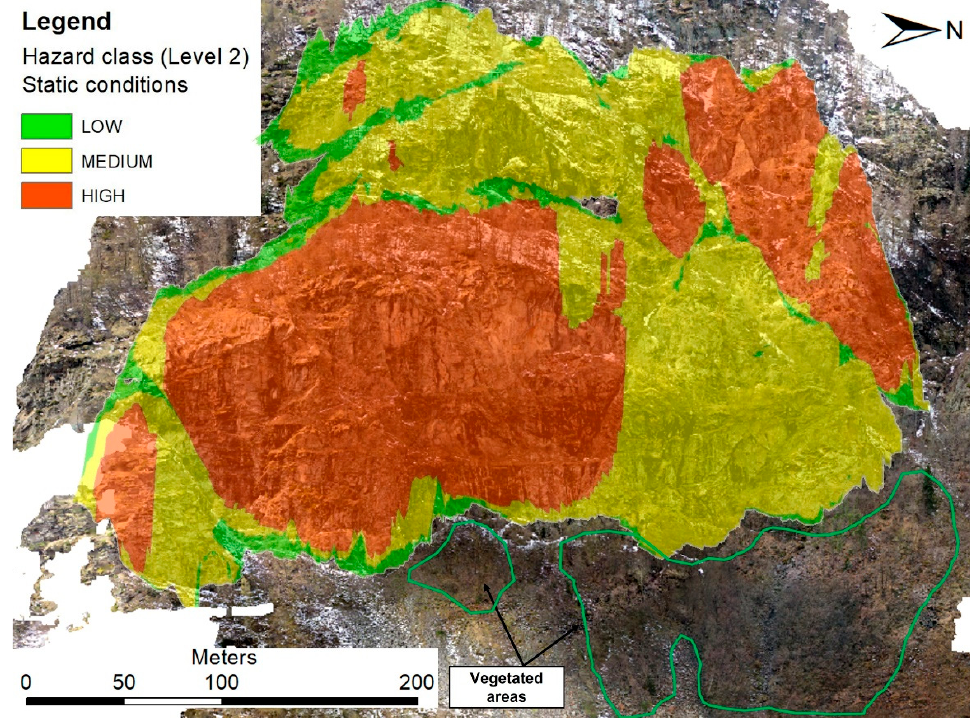
Figure 13. Level 2 hazard map, static conditions, with indication of the areas covered by vegetation.